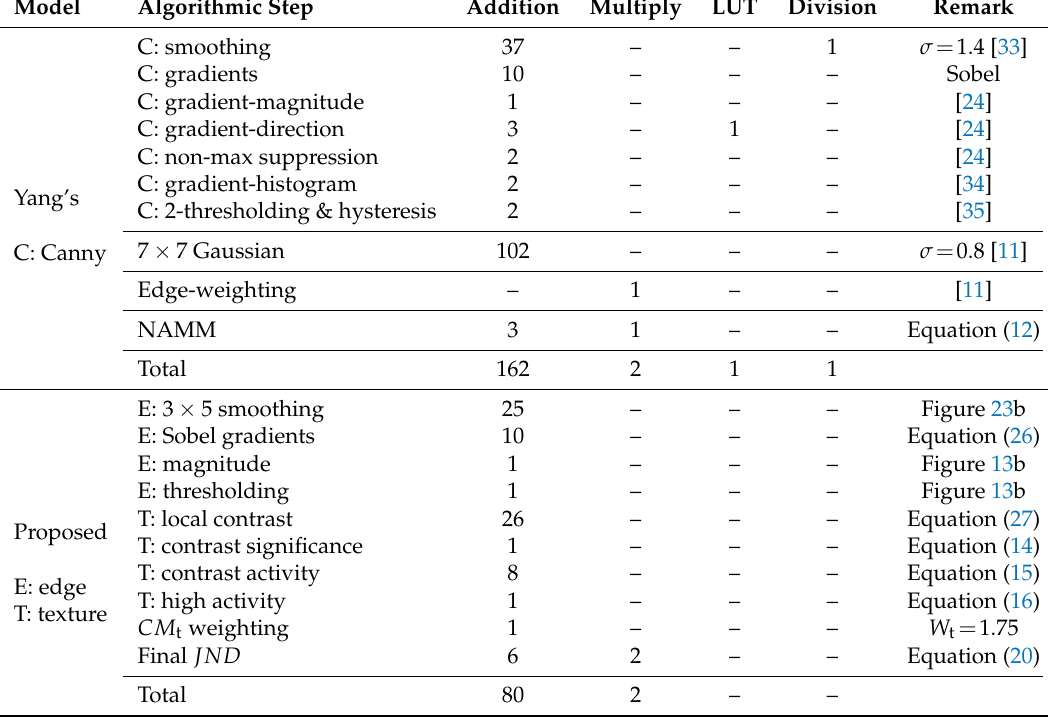
Table 4. Approximate number of additional operations per pixel required for computing a visibility threshold by Yang et al.’s JND model and the proposed